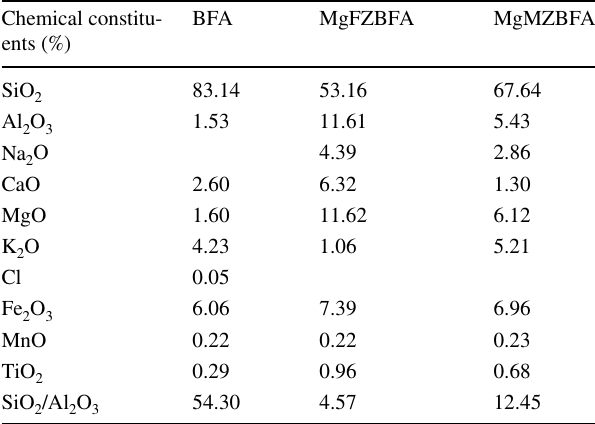
Table 1 Chemical compositions of BFA, and the synthesized adsor- bents MgFZBFA and MgMZBFA Chemical constitu- ents (%)